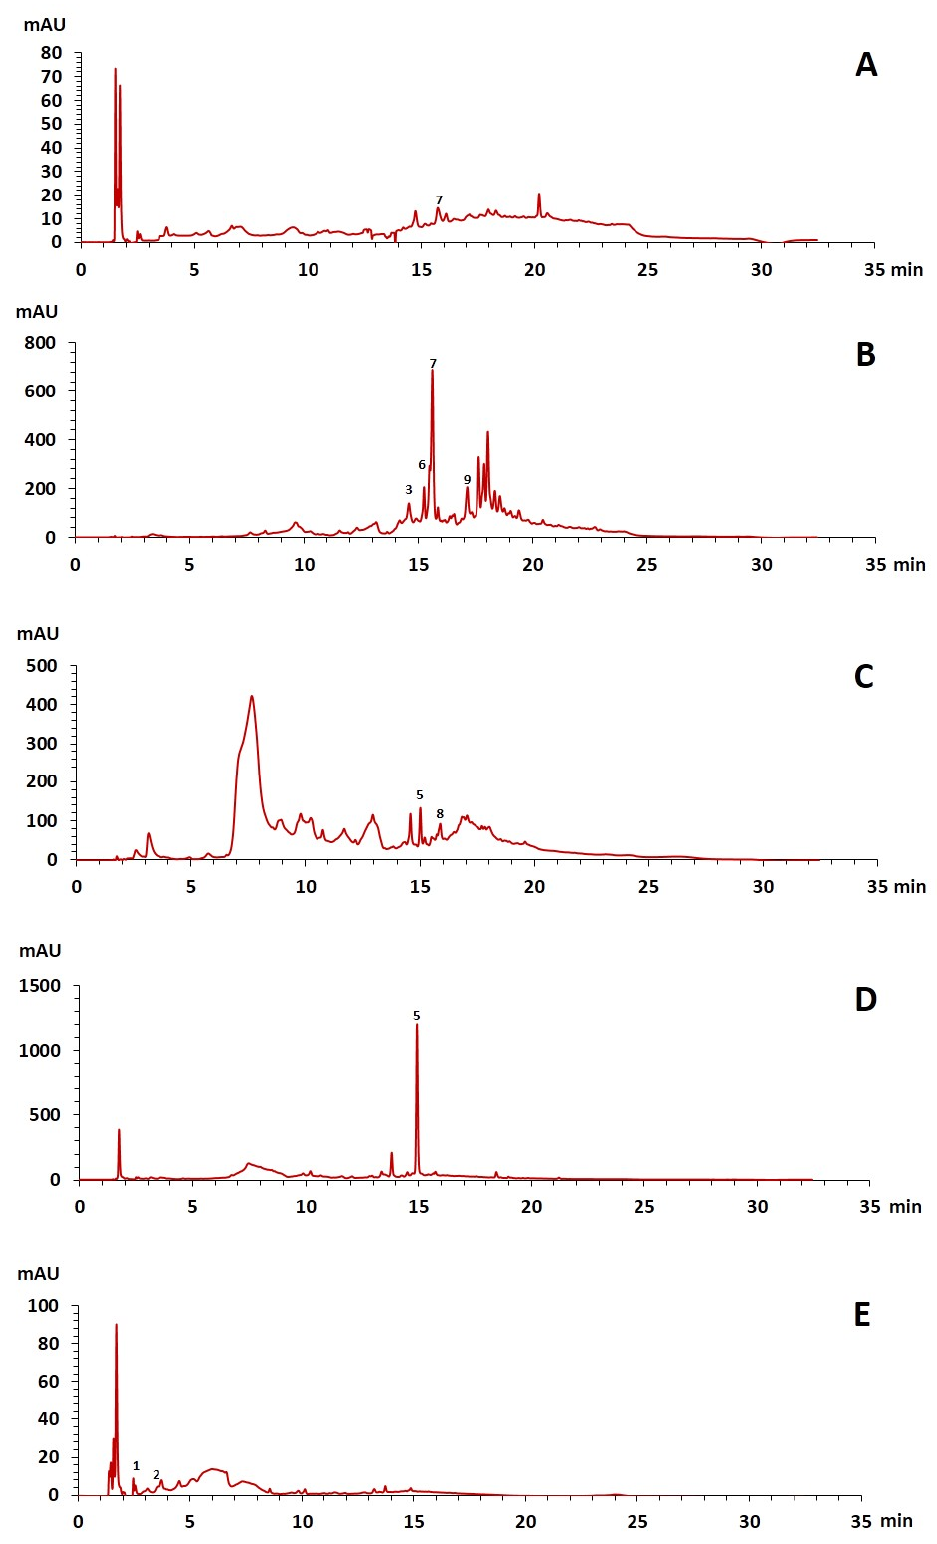
Figure 2. HPLC-DAD-UV analysis (280 nm) of phenolic compounds in ethanol extract ( A ), chloroform ( B ), ethyl acetate ( C ), n -butanol ( D ), and water ( E ) fractions of leaves of L. intricatum. Gallic acid ( 1 ), gentisic acid ( 2 ), catechin ( 3 ), rutin ( 5 ), gallocatechin gallate ( 6 ), quercetin ( 7 ), ferulic acid ( 8 ), trans -cinnamic acid ( 9 ). The experimental conditions are described in Section 2.5.